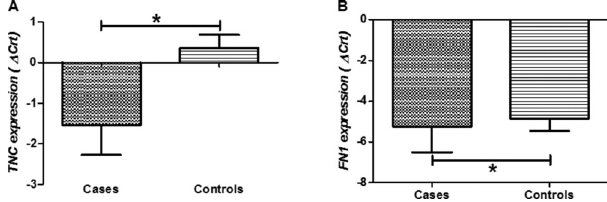
Figure 1 - TNC (A) and FN1 (B) expression levels in capsule samples collected from patients with adhesive capsulitis and controls. A lower delta cycle threshold value ( D Crt) indicates higher gene expression. Box plots show the median and interquartile range. *A significant difference between groups by Mann-Whitney test ( p o